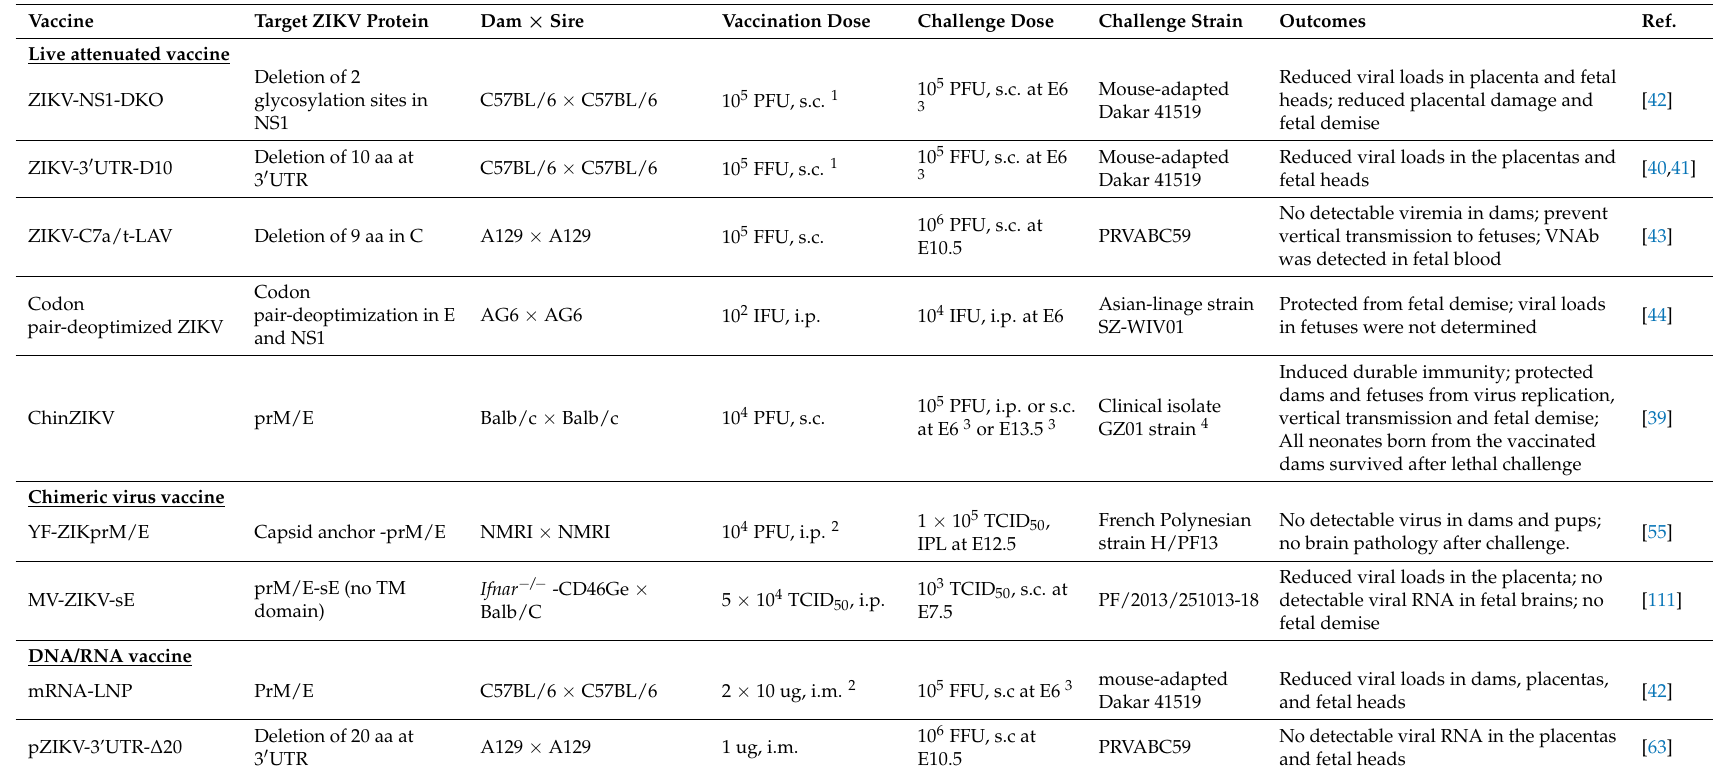
Table 2. Vaccines protective against ZIKV infection during mouse